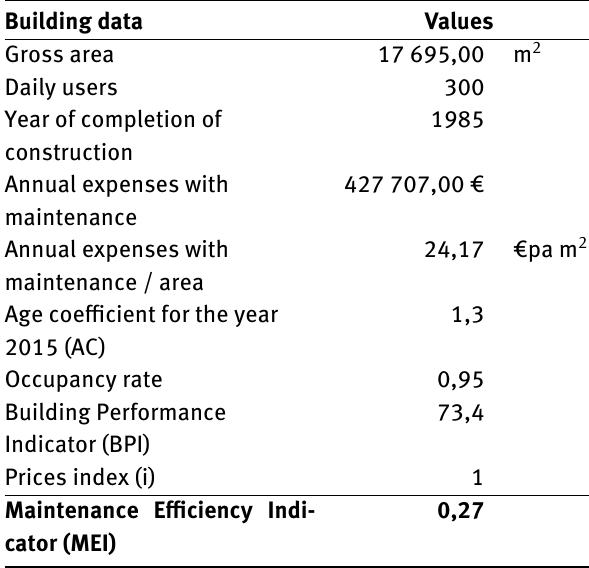
Table 8: Data used in the calculation of